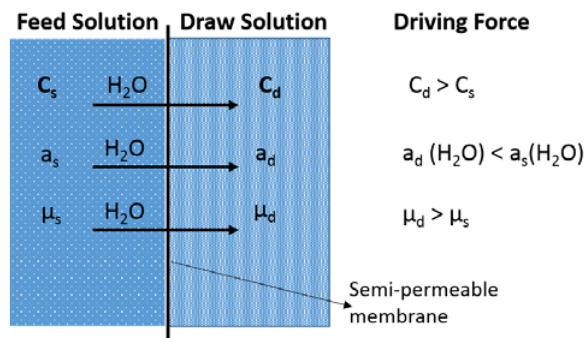
Figure 3. Schematic representation of the driving force involved in FO in an ideal system where only water (H the membrane (i.e. 100% solute rejection by the membrane).